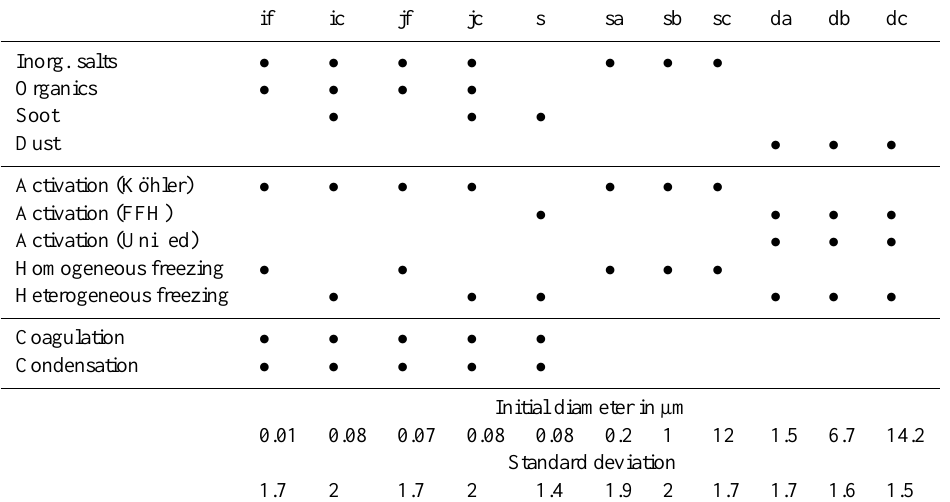
Table 1. Overview of the individual aerosol modes, their chemical composition (first block), the involved cloud interaction processes (second block), aerosol dynamical processes (third block), and their initial diameter and standard deviation (fourth block). The model framework includes secondary aerosol and soot modes (if, ic, jf, jc, and s), sea salt modes (sa, sb, and sc) and dust modes (da, db, and dc).